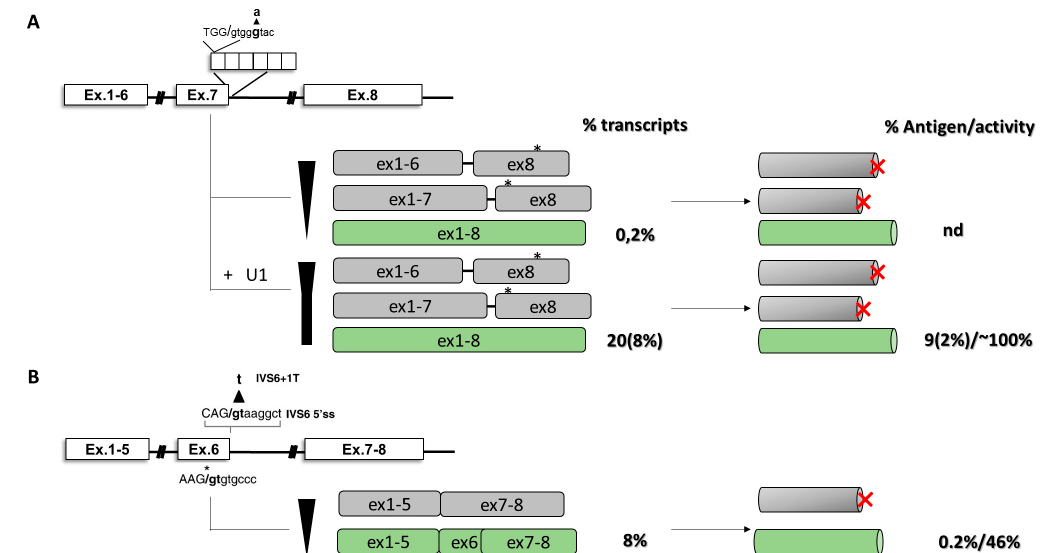
Figure 5. U1-mediated rescue in coagulation FVII deficiency. Coagulation FVII deficiency caused by c.859 + 5G > A ( A ) and c.681 + 1G > T ( B ) nucleotide changes in the F7 gene. Schematic representation of the genomic context (left panel), splicing transcripts (middle panel) and protein isoforms (right panel) is reported. Sequences of the splice sites and position of mutations are indicated. Frameshift of the coding sequence and premature stop codons are reported by asterisks and red X letter, respectively. Percentages of transcripts, antigen and relative coagulation activity are reported.